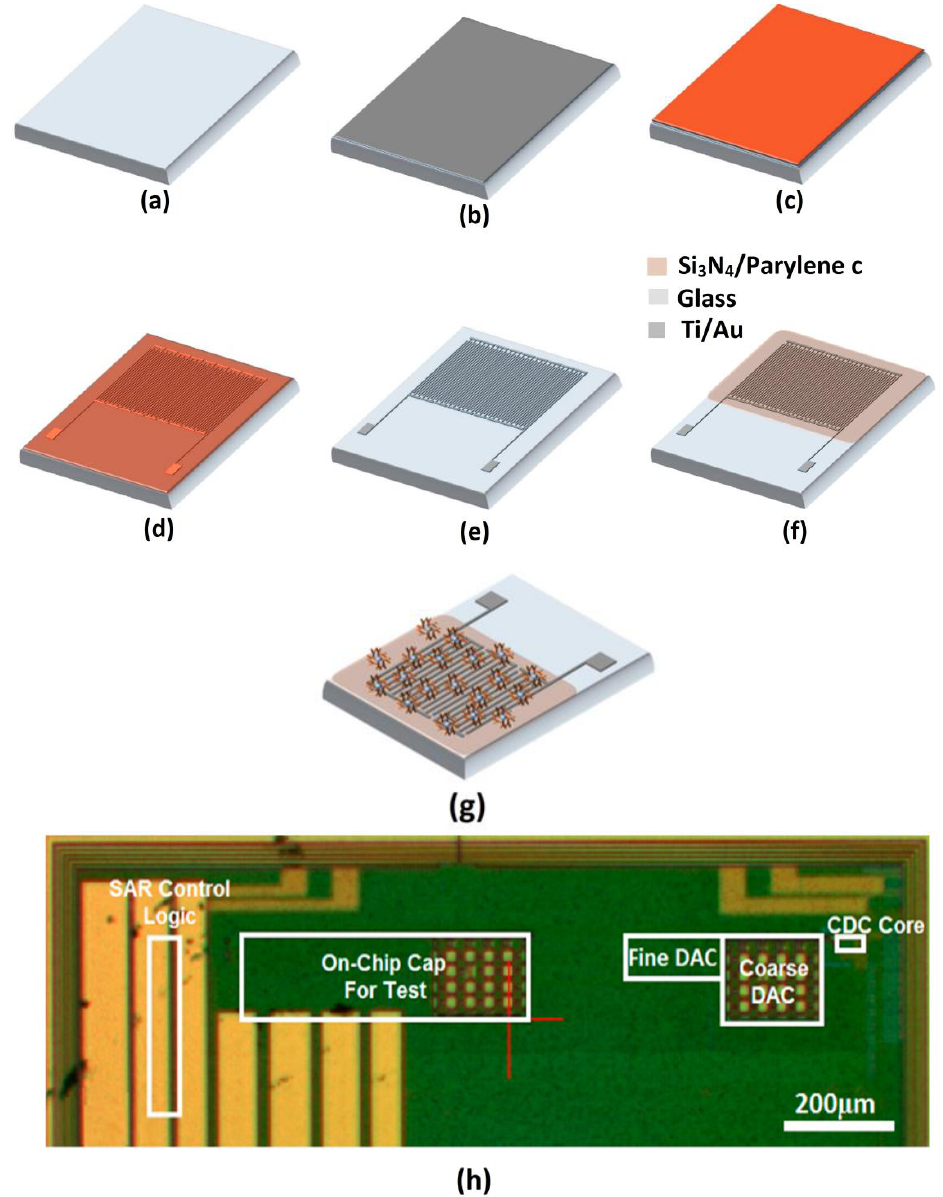
Figure 8. Fabrication procedure of CMOS capacitive biosensor using photolithography: ( a ) cleaned glass substrate; ( b ) sputtering deposition of electrode terminals such as Ti and Au; ( c ) coating of photoresistor; ( d ) patterning of the resistor; ( e ) after photoresistor development, dry etching and removal of the resistor; ( f ) dielectric deposition and realization of the capacitive sensor array with interdigitated electrodes; ( g ) immobilized antibodies on the sensor surface; ( h ) packaged sensor chip mounted on the printed circuit board. Reproduced from [74] under the Creative Commons Attribution License.